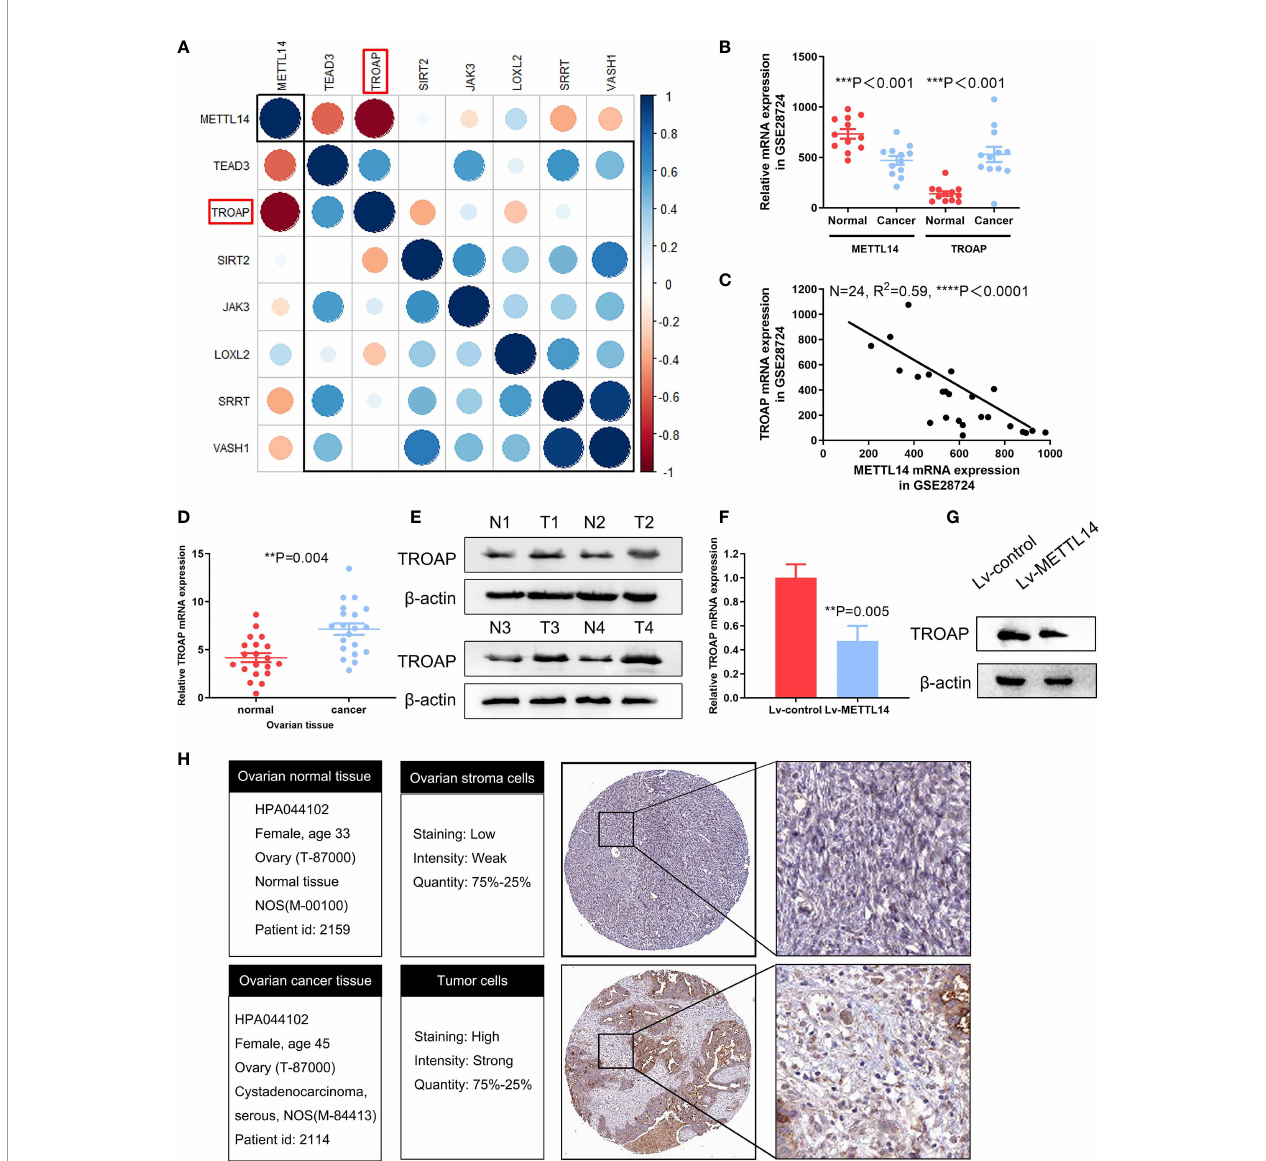
FIGURE 4 | Con fi rmation of TROAP as a downstream target of METTL14. (A) Correlation matrix of candidate genes for each biological process phenotype strati fi ed by expression levels of cell proliferation-related genes, which were measured by qRT-PCR. Blue indicates a positive correlation, and red indicates a negative correlation. In addition, brightness is proportional to correlation strength. TROAP is indicated in the red box. (B) Graph displaying the negative correlation between TROAP (probe ID: 202265_at) and METTL14 (probe ID: 241689_at) expression in 34 types of ovarian cancer cell lines from the GEO dataset (GSE28724) (*** P < 0.001). (C) Expression levels of TROAP are negatively correlated with METTL14 in human ovarian cancer lines GEO dataset (GSE28724) (**** P < 0.0001). (D, E) Analysis of TROAP at the mRNA level (D) and protein level (E) in normal and cancer ovarian tissue. (F) TROAP mRNA expression levels in METTL14-overexpressing SKOV-3 cells (** P = 0.005). Graphical data represented as the mean ± SD. (G) Western blot of TROAP protein expression levels. (H) Comparison of relative TROAP expression between ovarian cancer and normal tissues in The Human Protein Atlas